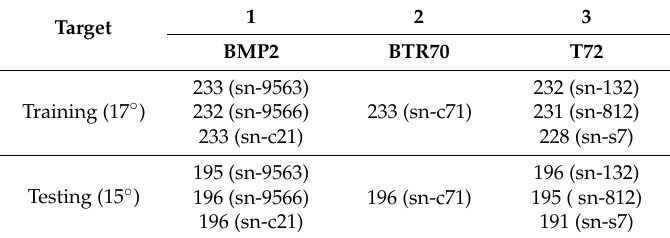
Table 1. The types and numbers of training and testing data sets.